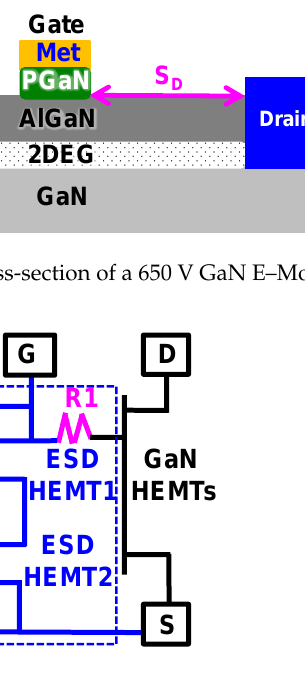
Figure 2. Schematic diagram of a 650 V GaN HEMT with the gate ESD protection circuit.